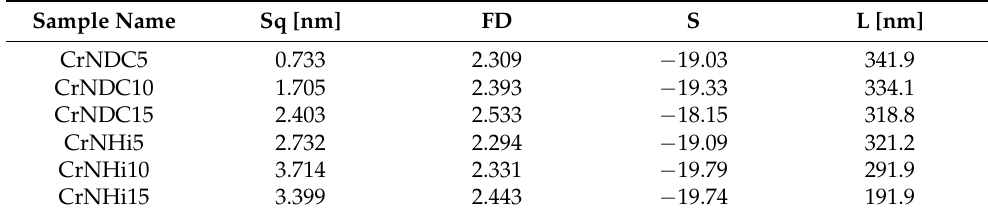
Table 6. Roughness (Sq), fractal dimension (FD), entropy (S) and autocorrelation length (L) of surface topography for each sample.